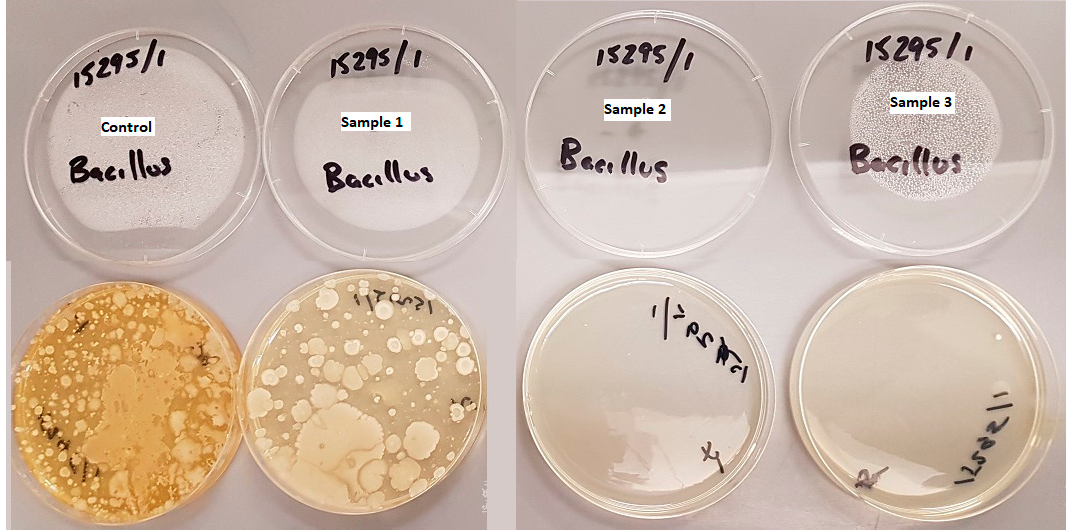
Figure 11. Comparison of Bacillus spp present in samples.